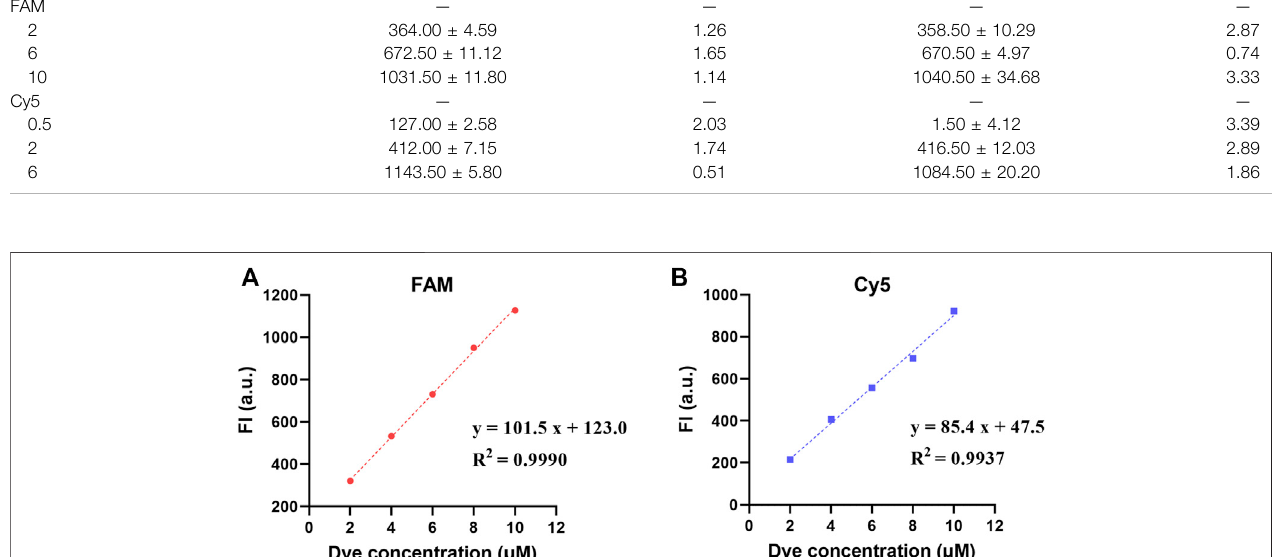
Frontiers in Bioengineering and Biotechnology |